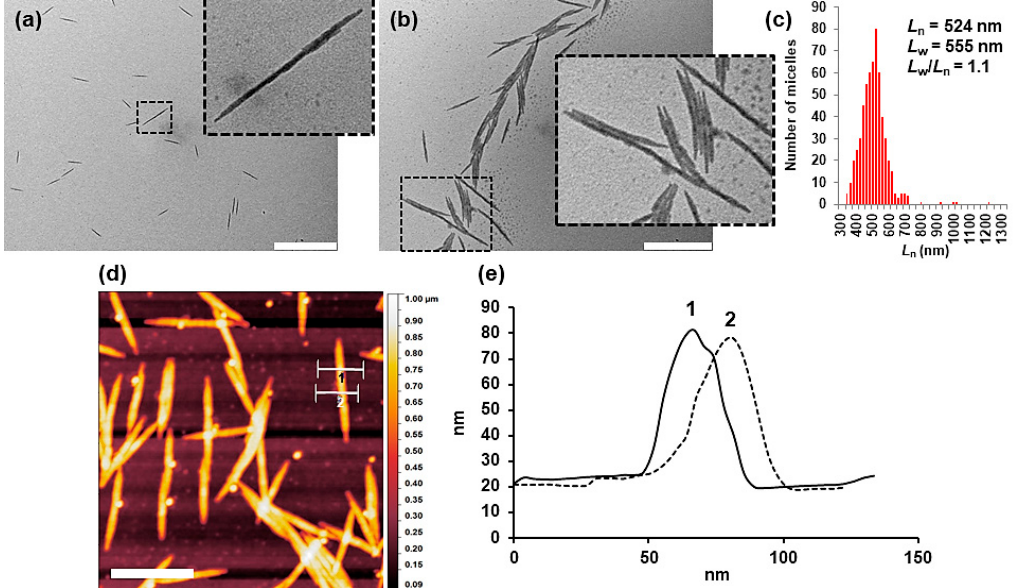
Figure 4. ( a , b ) Bright field TEM images of drop-casted solution of cylindrical micelles prepared by the self-assembly of BCP 8a (0.25 mg/mL) in mixtures THF/2-propanol = 1/1. Inside figures correspond to higher magnification of the squared areas in ( a ) and ( b ). Inside scale bars correspond to 1000 ( a ) and 500 nm ( b ). ( c ) Histogram of micelles length ( N = 500). AFM height image ( d ) and AFM cross-sectional height profiles ( e ) across one of the cylindrical micelles. Inside scale bar corresponds to 500 nm ( d ).